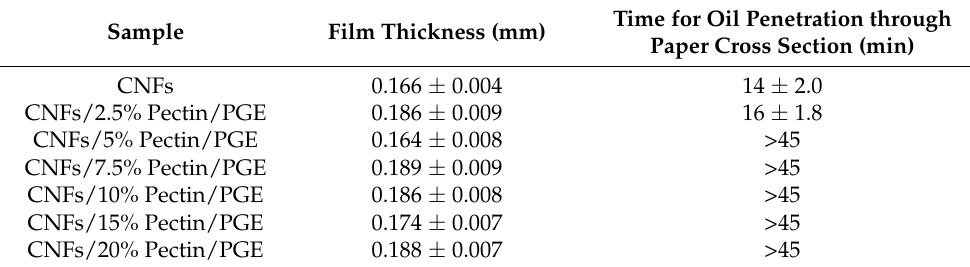
Table 6. Greaseproof results of CNFs/Pectin/PGE films.